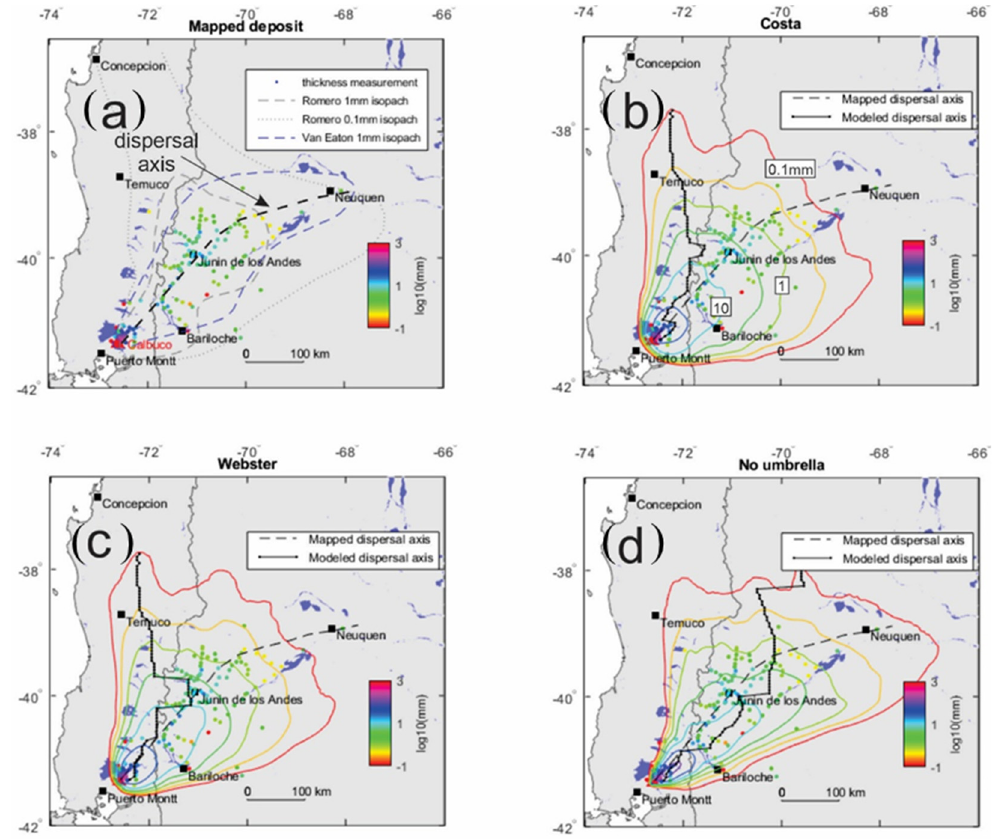
Figure 6. ( a ) extent of deposits from the 2015 Calbuco eruption, mapped by Van Eaton, et al. [9] and Romero, et al. [10]. Blue dashed line is the 1 mm isopach line mapped by Van Eaton et al.; gray dashed line is the 1 mm isopach mapped by Romero et al.; gray dotted line is the 0.1 mm isopach mapped by Romero et al. Colored dots are mean values of a thickness range at each location given by Van Eaton, et al. [9]. Colors correspond to thickness as indicated in the color bar on the right. ( b ) Modeled thickness isopachs (colored lines) resulting from Ash3d simulation considering growth of an umbrella cloud and radial winds within the cloud as given in Equation (3). All other inputs are as given in Table 3. Thickness values assume a deposit density of 800 kg m − 3 . Isopach colors correspond to thickness as given on the color bar, with values of 0.1, 0.32, 1, 3.2, 10, and 32 mm from outer to inner. Colored dots show measured sample thicknesses, using the same color scale as the isopachs. Black dashed line is the dispersal axis mapped by Van Eaton, et al. [9]. Black solid line is the dispersal axis of the modeled deposit, determined by finding the cell in each row of cells with the greatest deposit thickness, and drawing a line connecting those cells. ( c ) Thickness isopachs derived from an Ash3d simulation that considers growth of an umbrella cloud and radial winds as given in Equation (4). ( d ) Thickness isopachs resulting from an Ash3d simulation that does not include umbrella growth. Height used in ( b , c ) is that of the umbrella-top—16 km asl. Height used in ( d ) is the plume top—25 km asl.